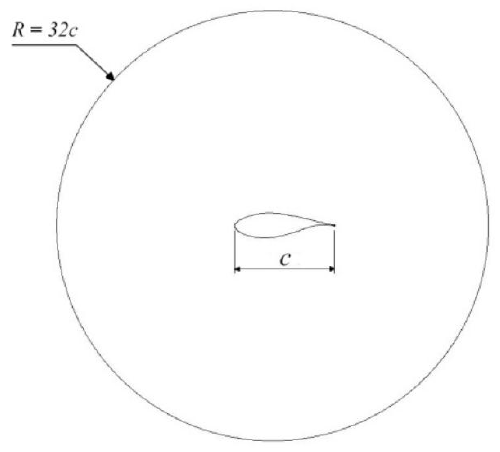
Figure 2. Computational domain size (not to scale).